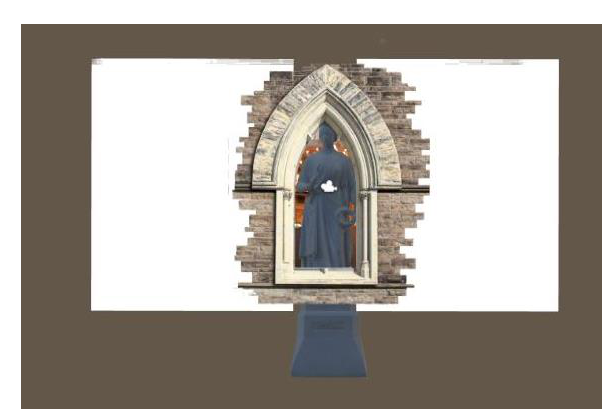
Figure 6. Unity scene without occlusion mask.